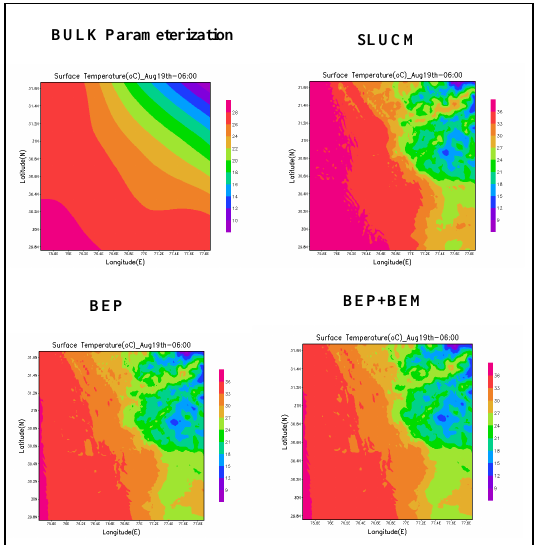
Figure 3: Spatial distribution of Temperature at 2m with four Urban physics schemes over d02 on August 19 th 11:30